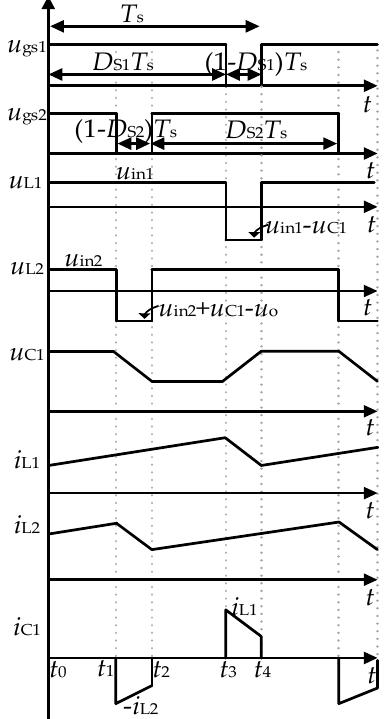
Figure 3. The main waveforms in one switching period T s .